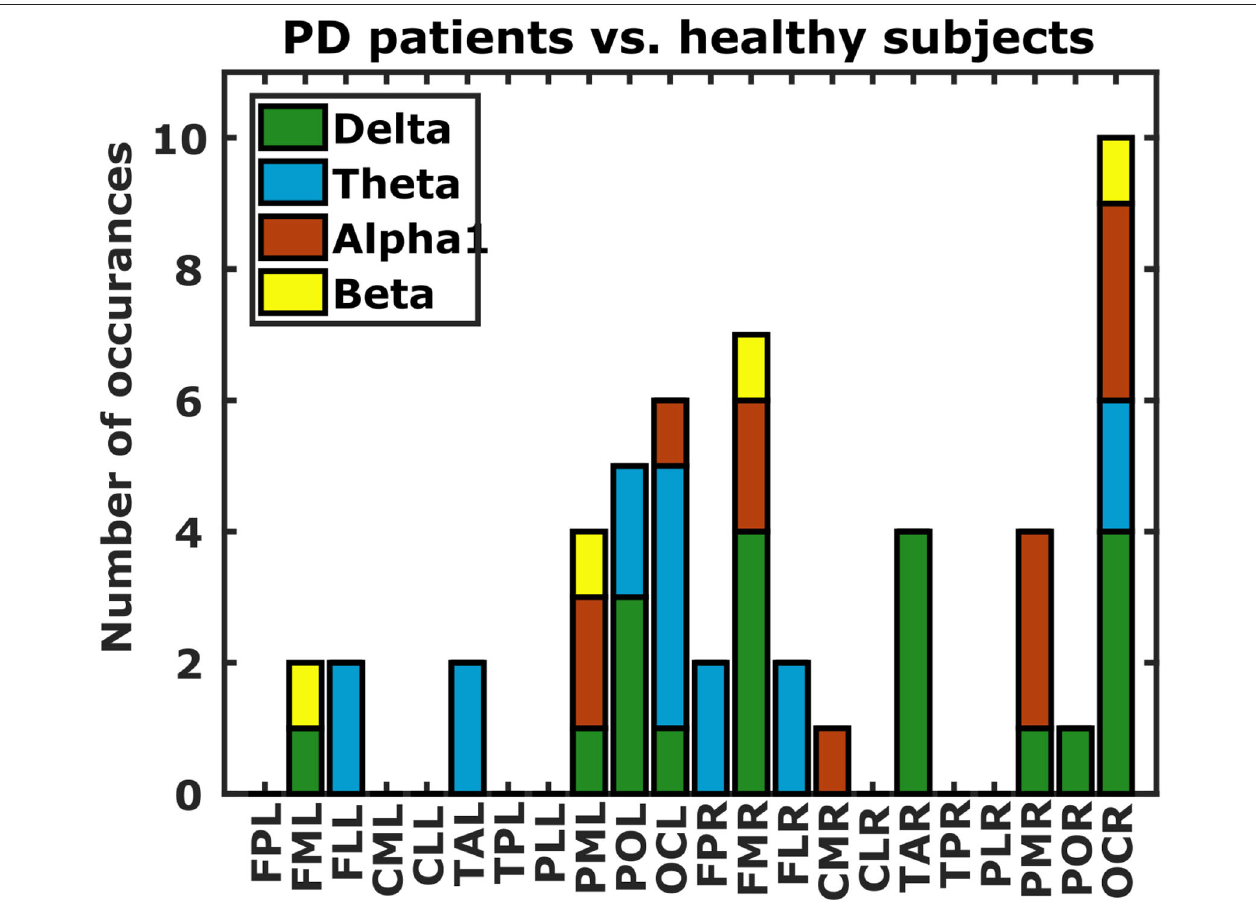
FIGURE 7 | Differences in DFC profiles from PD patients and healthy subjects. Each bar indicates the number of occurrences of each of the 22 scalp regions in the set of DFC coefficients that are statistically different between PD patients and healthy subjects. Bar colors correspond to frequency bands. L, left hemisphere; R, right hemisphere; FP, fronto-polar; FM, frontal-mid; FL, frontal lateral; CM, central mid; CL, central lateral; TA, temporal anterior; TP, temporal posterior; PL, parietal lateral; PM, parietal mid; PO, parietal occipital; OC,